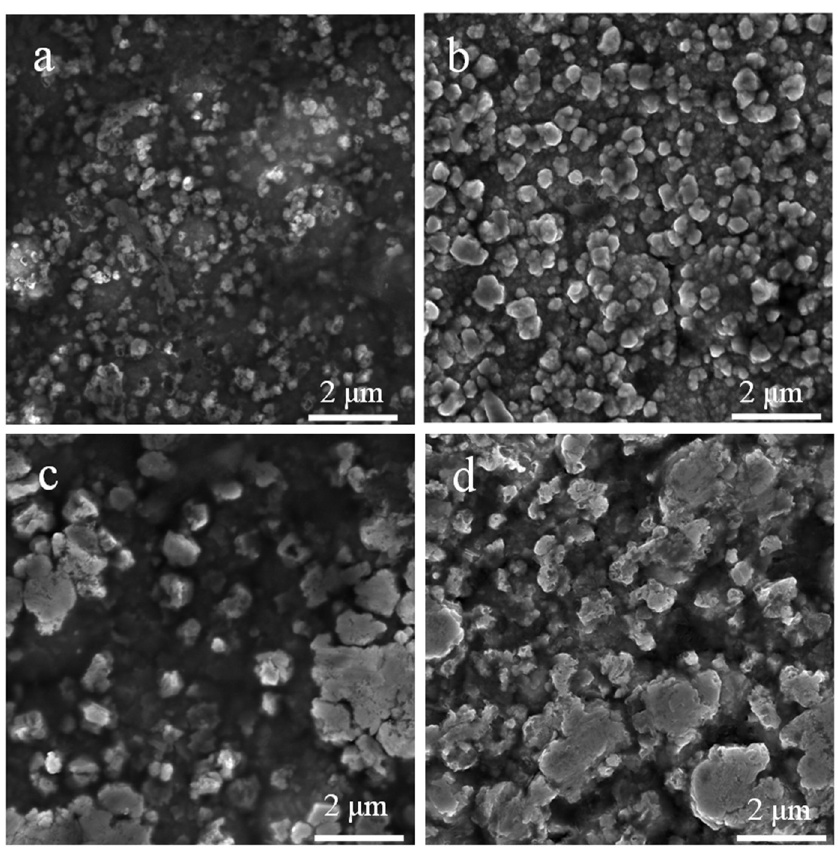
Figure 4. FESEM spectra of Au (0.0, 0.5, 1.0 and 1.5 wt%)-doped ZnO–Sm nanoparticle films.